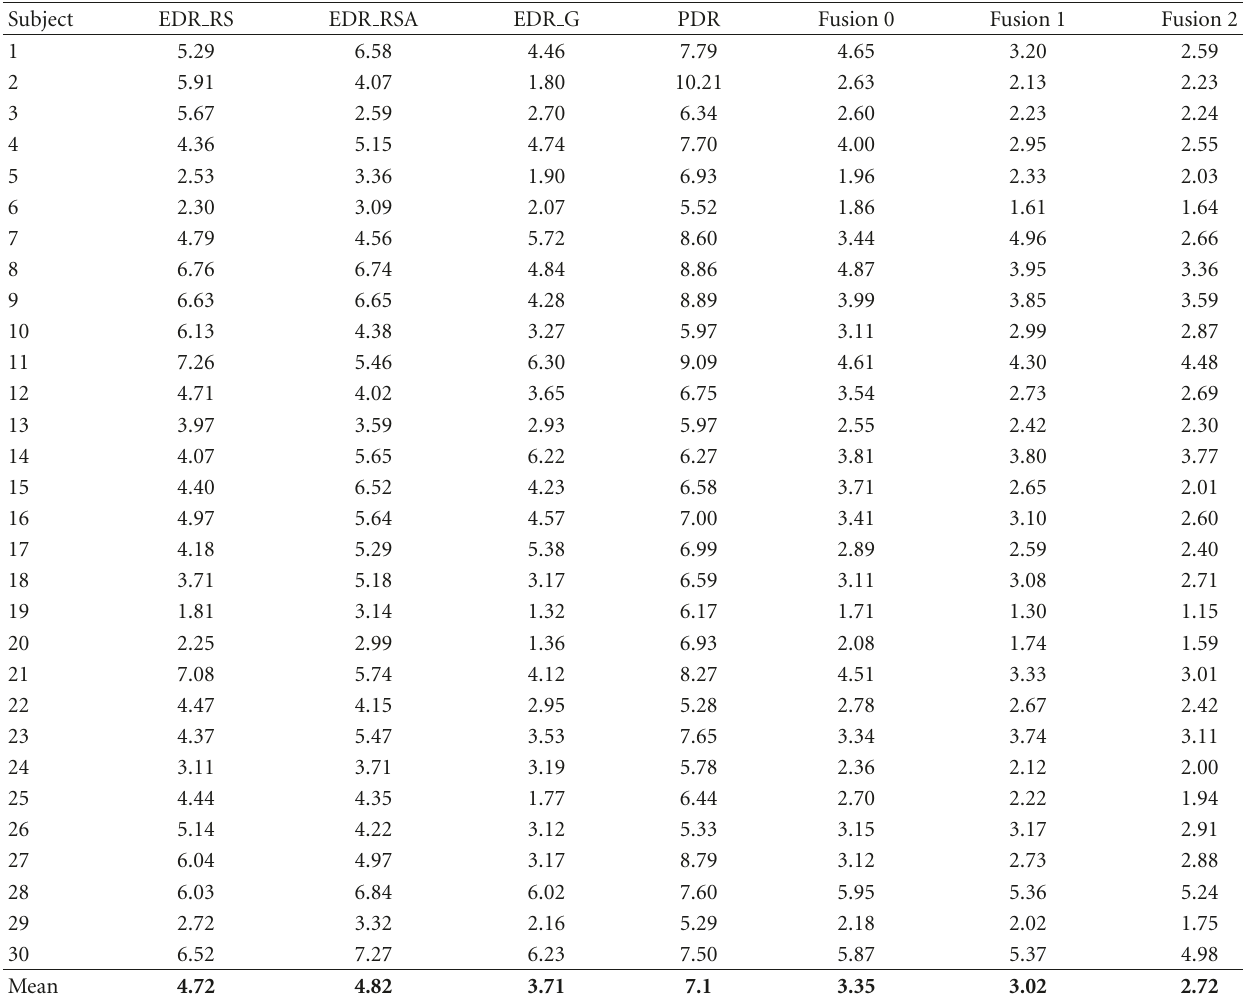
Table 2: Overall performance summary of each algorithm individually and the fusion results using the signal quality indices. Fusion 0 indicates usage of no SQI ( Γ = 1), Fusion 1 indicates usage of ECG SQI to determine the quality of the respiration estimates derived from the ECG waveform, and Fusion 2 indicates usage of the purity index for the estimates derived from the ECG waveform. Note that the Hjorth parameters are used for PAT SQI throughout. All values quoted are in RMS